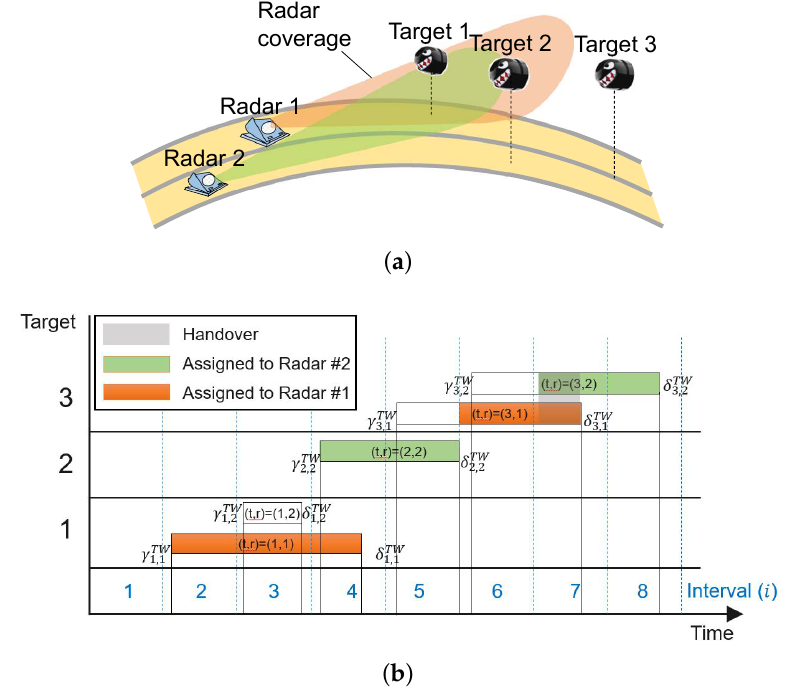
Figure 3. Conceptual diagram for sensor assignment considering target handover (refer to Table 1 for definitions of the symbols). ( a ) Physical circumstance description. ( b ) Description of time windows and handover procedure for seamless